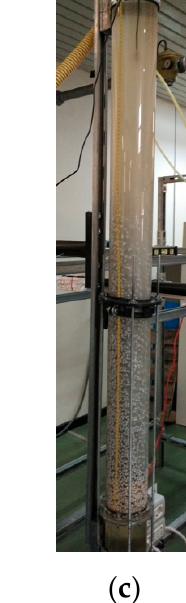
Figure 5. Photographs of a typical fluidization behavior for a mixture of fine glass beads (GB1) and light plastic spheres (PS1): ( a ) fully segregated condition at low water velocity; ( b ) mixed condition at intermediate velocity; ( c ) expanded inverted layers condition at high velocity .